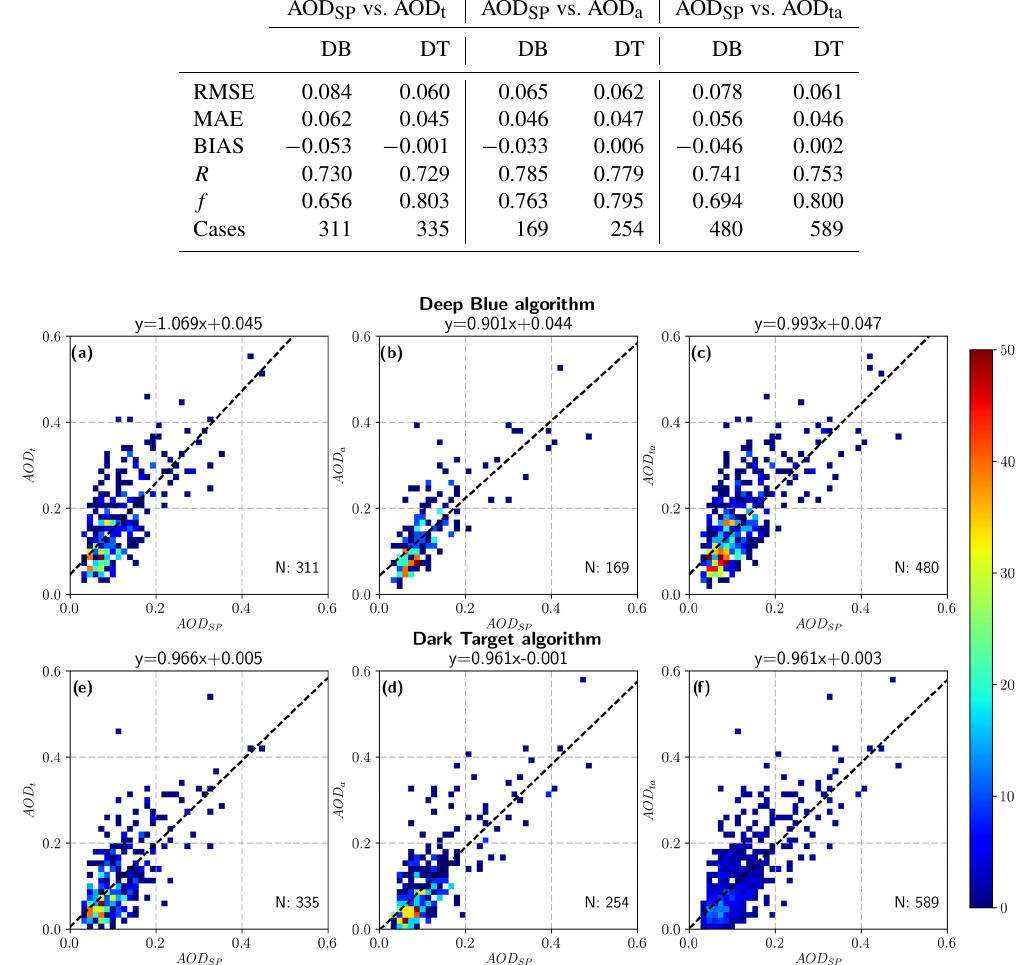
Figure 3. Collocated daily mean density scatter plots of the coincident AOD observations from the sun photometer and Terra and Aqua MODIS instruments for DB and DT algorithms: (a) to (c) show AOD SP vs. AOD t , AOD a and AOD ta respectively for the DB algorithm; (d) to (f) show the same for the DT algorithm. The data density is represented by the colour scale, showing the number of data points located in a particular area of the plot. Linear regression is given by the black discontinuous line and the corresponding equation. The number of data points appears in the right